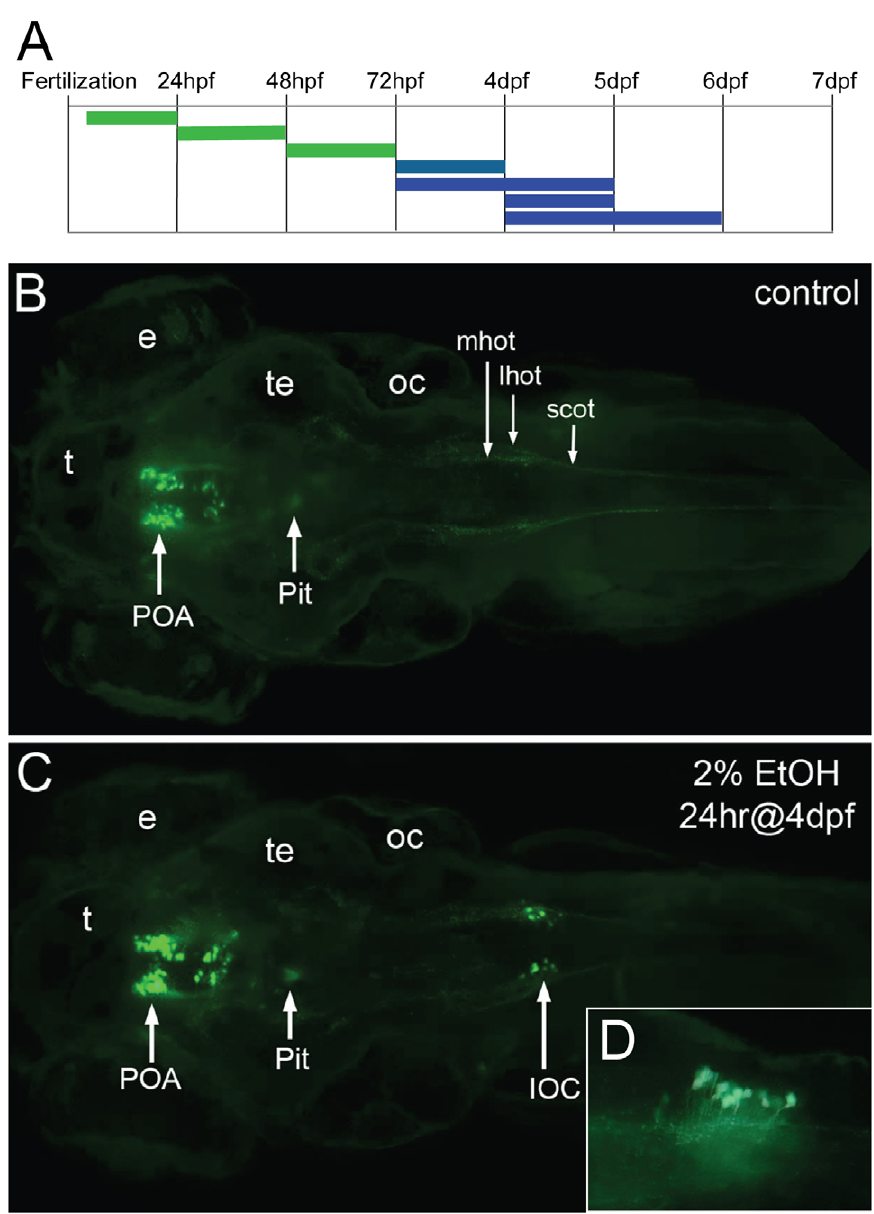
Figure 7. Expression of the oxtl:GFP transgene is induced in the hindbrain by exposure to ethanol. A , the duration and embryonic stage of 2% ethanol treatments are illustrated with solid bars. Oxtl:GFP expression in the neuroendocrine preoptic area was unaffected with all treatments (green), while oxtl:GFP was induced in the hindbrain by later treatments (blue). B, C , Tg(oxtl:GFP) larva shown at 6 dpf, dorsal views. B , control embryo, C , treated with 2% ethanol for 24 hrs at 4 dpf. A small group of large GFP-expressing neurons appears in the hindbrain of the ethanol- treated larva. We call these ethanol-induced GFP-expressing neurons, induced oxytocin cells (IOC). D, inset , a higher magnification view of the IOCs shows processes that appear to enter the hindbrain oxytocinergic tracks, lateral view. Eyes (e), lateral hindbrain oxytocinergic tract (lhot), medial hindbrain oxytocinergic tract (mhot), otic capsule (oc), pituitary (Pit), preoptic area (POA), spinal cord oxytocinergic tract (scot), tectum (te), telencephalon